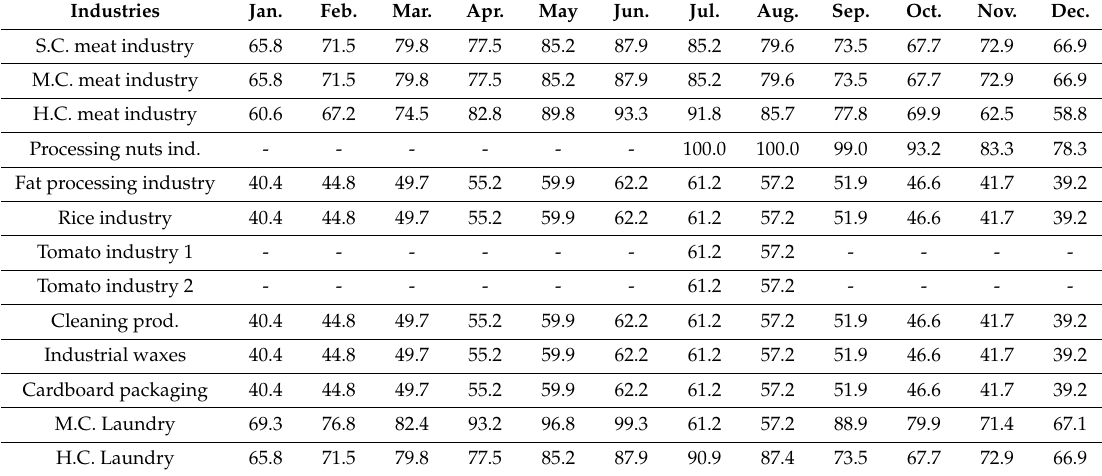
Table 5. Percentage of production time in solar time.